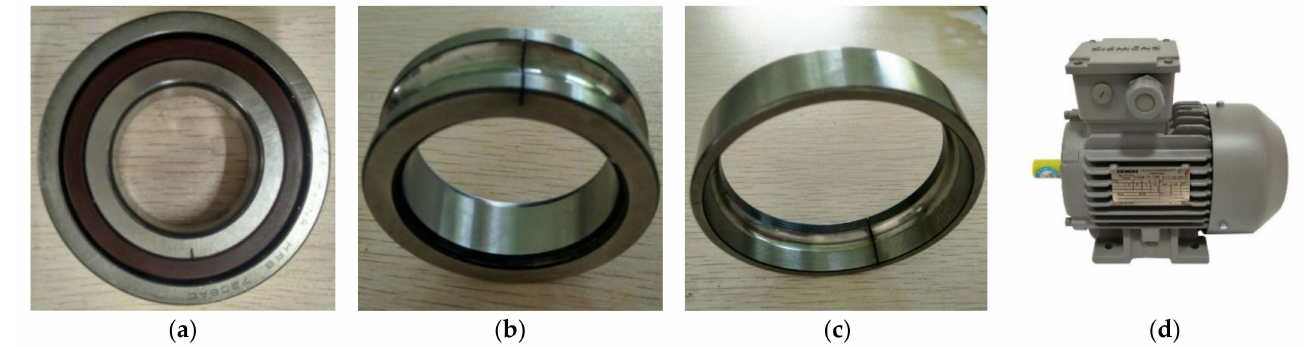
Figure 11. ( a ) The tested rolling bearing. ( b ) the inner ring. ( c ) the outer ring. ( d ) the alternating current variable frequency